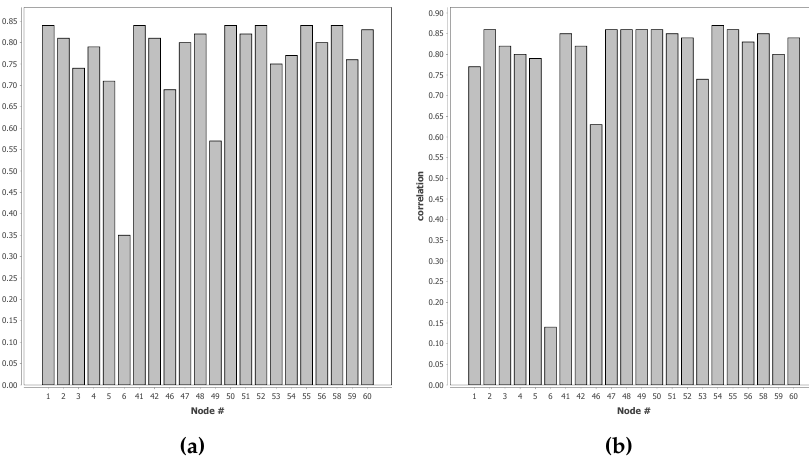
Figure 6. Correlation of class distributions over intervals for the numbered node on the x -axis with all other nodes trained using supervised learning. High correlation is an indication that the classifiers work in a similar manner; ( a ) Correlation for AAV (Assault Amphibian Vehicle) vehicles; ( b ) Correlation for DW (Dragon Wagon) vehicles.